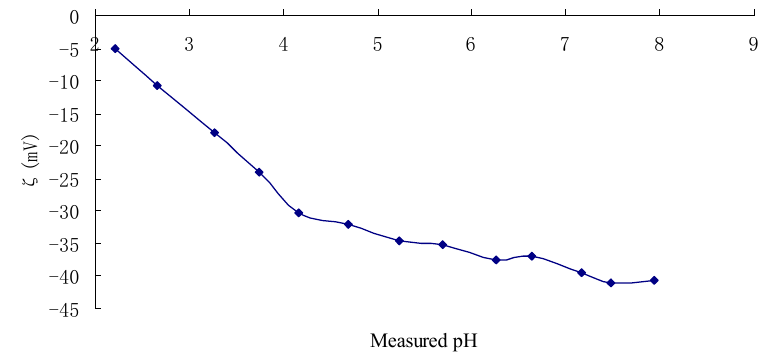
Figure 3. Zeta potentials of TPC-A as a function of pH 2.0–8.0 at an interval of 0.5.